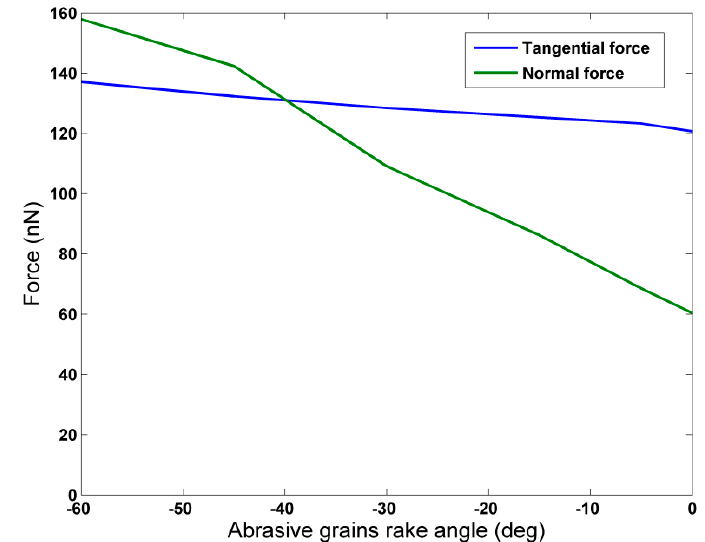
Figure 6. Grinding force components in respect to abrasive grains rake angle.